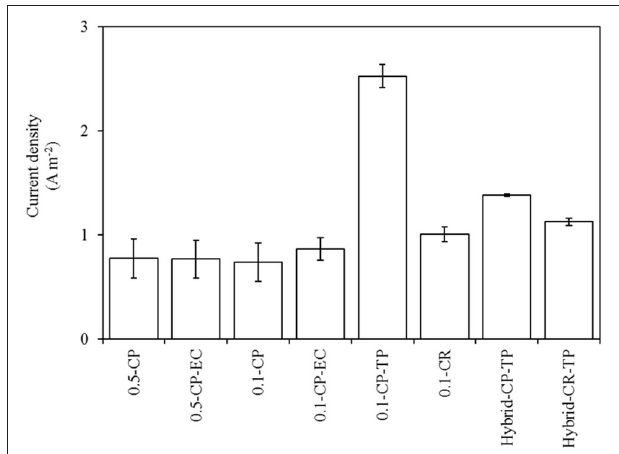
FIGURE 6 | Mean current densities for 24h after the last feeding event for batch fed experiments, and for the last 24h of the continuously fed experiments (as shown in Supplementary Figure 1 ). Error bars show the standard deviations of current